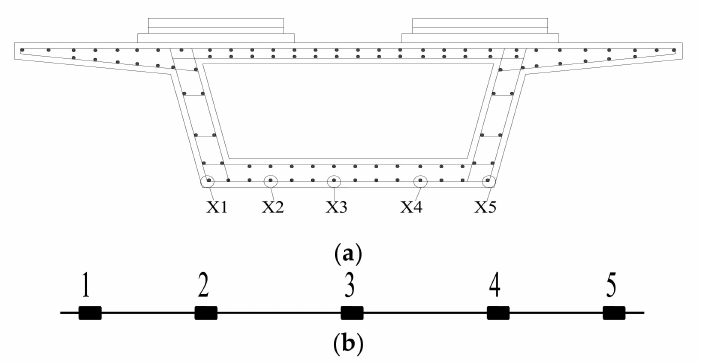
Figure 2. Layout of rebar strain measuring points: ( a ) Strain measurement point map on rebar steel; ( b ) strain measurement point diagram of rebar